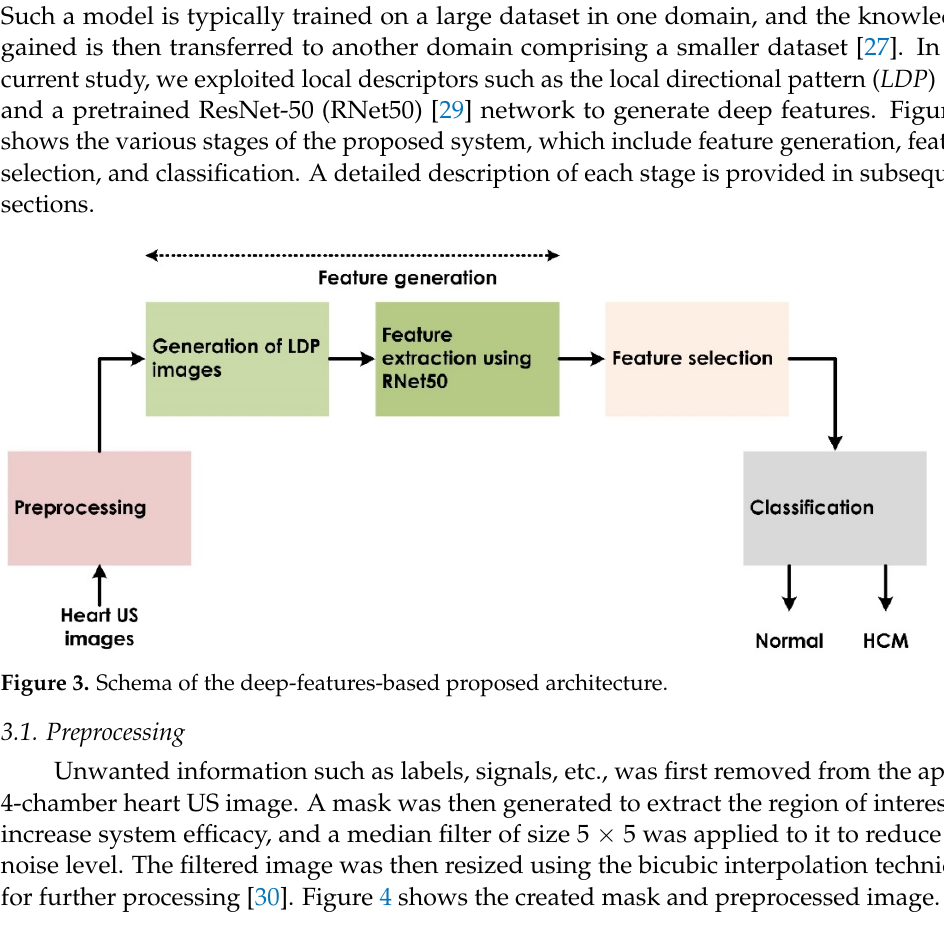
Figure 2. Example apical 4-chamber US images of normal versus hypertrophic cardiomyopathy par- ticipants.